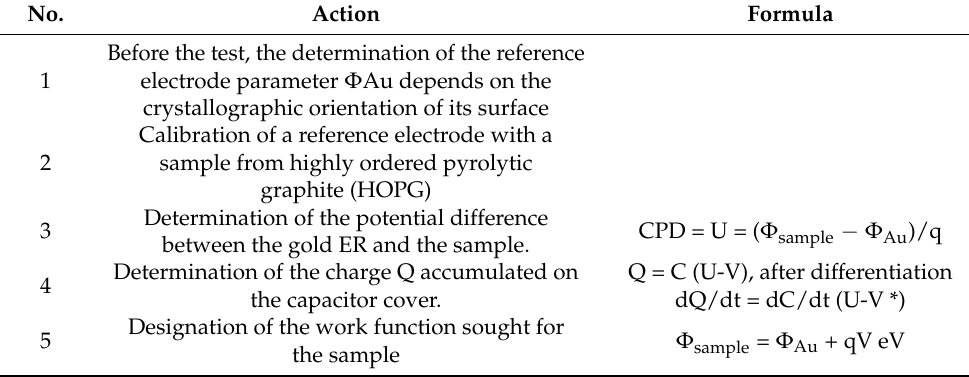
Table 1. Formulae and quantities characterising the tested sample’s work function [8–11].